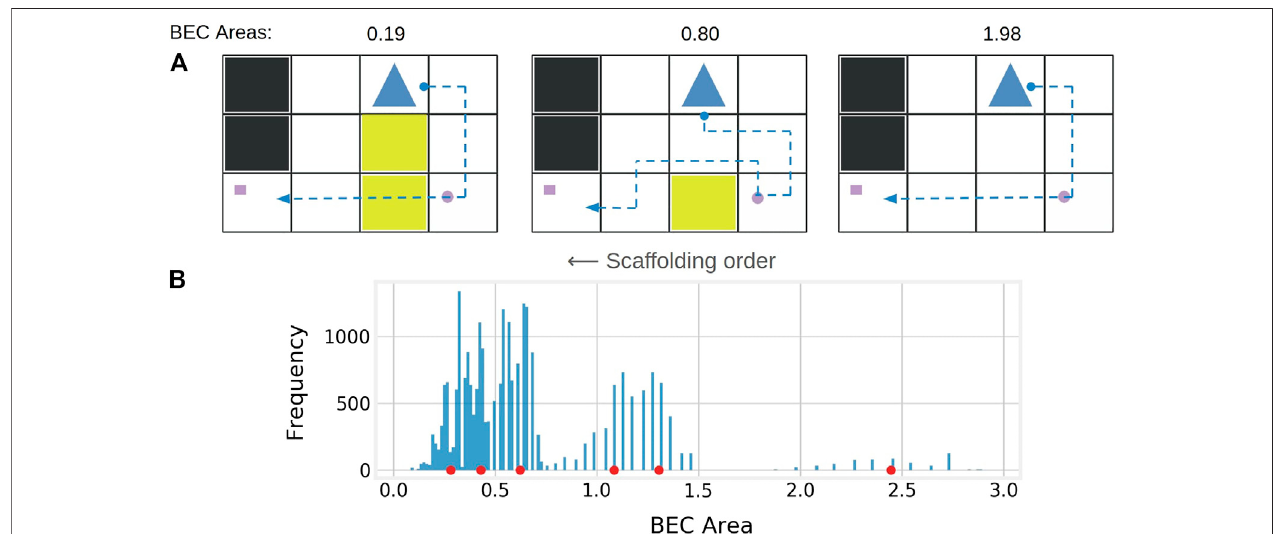
FIGURE2|(A) Sampledemonstrationsexhibitingscaffolding,simplicity,andpatterndiscovery.Wescaffoldbyshowingdemonstrationsthatincrementallydecreasein BEC area (which appears to correlate inversely with informativeness and dif fi culty). Simplicity is encouraged by minimizing visual clutter (i.e. unnecessary mud patches). Patterndiscoveryisencouragedbyholdingtheagentandpassengerlocationsconstantwhilehighlightingthesingleadditionaltollbetweendemonstrationsthatchangesthe optimalbehavior. (B) HistogramofBECareasofthe25,600possibledemonstrationsinthedelivery domain.Clustercentersreturnedbyk-means(k (cid:1) 6)areshown